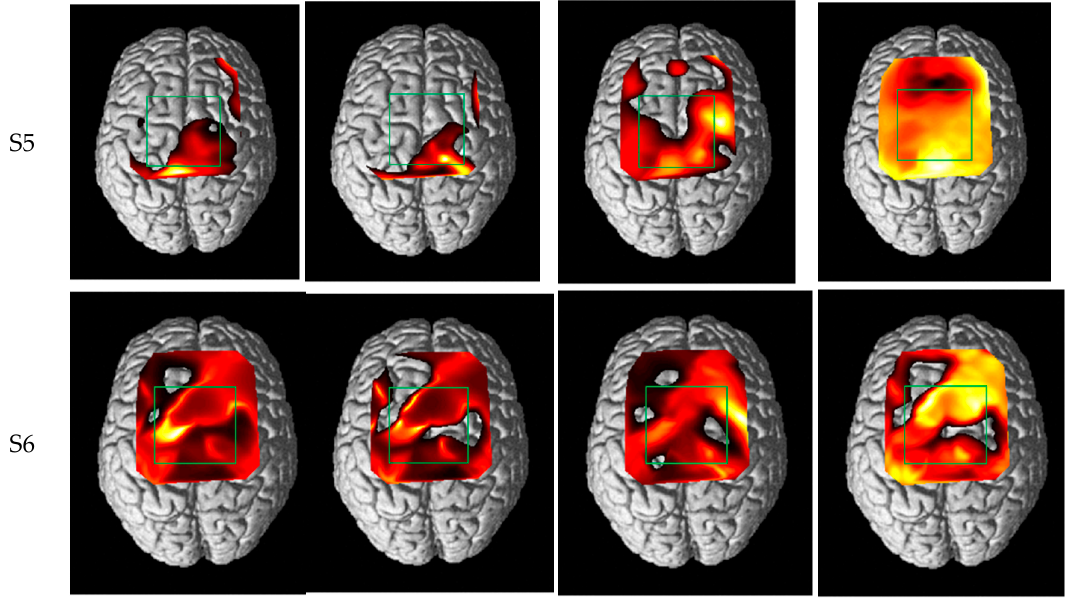
Figure 12. Brain activation map in comparing with conventional method and the proposed method (the green box: ROI).